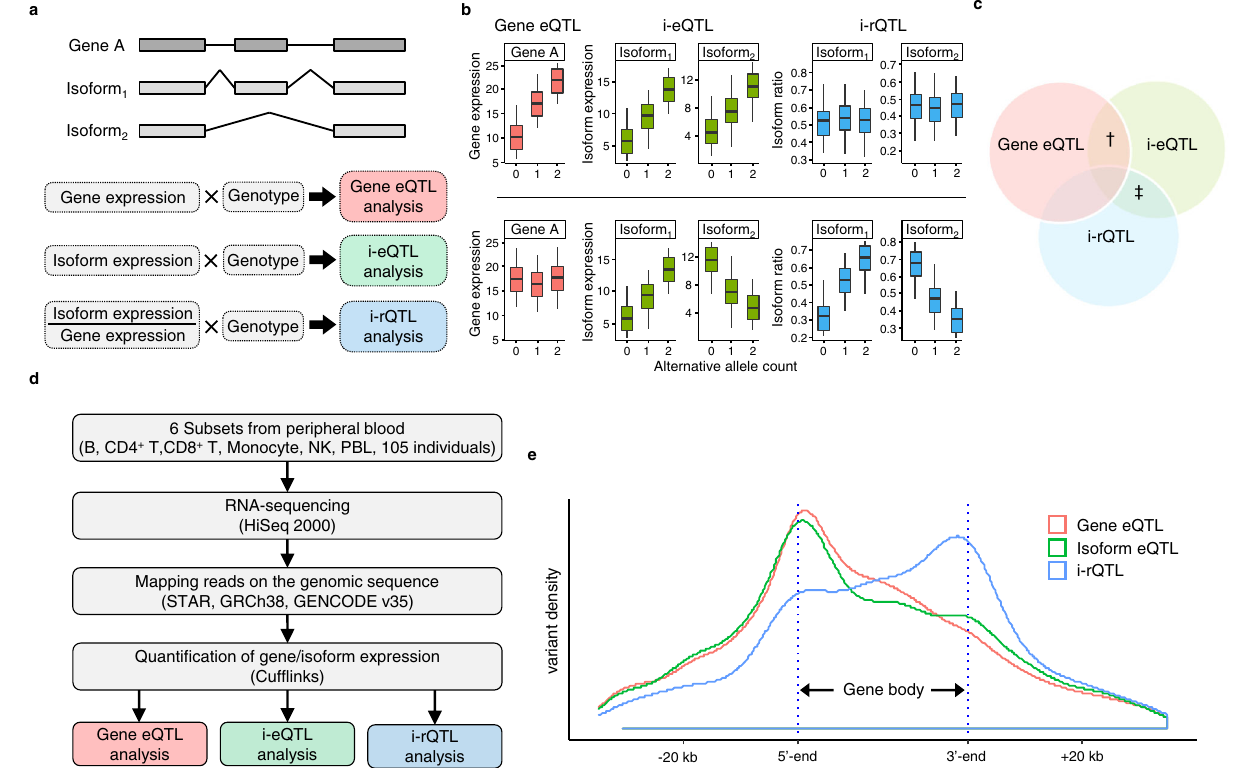
Fig. 1 | Three types of quantitative trait loci (QTLs); gene eQTL, isoform eQTL andi-rQTL.a GeneAhas2isoforms, isoform1 and isoform2.Alocus affectingthe expressionlevelofgeneAisde fi nedasgeneeQTL.Alocusaffectingtheexpression levelofisoform1and/or2isde fi nedasi-eQTL(isoformeQTL).Alocusaffectingthe isoform ratio of isoform 1 and/or 2 is de fi ned as i-rQTL (isoform ratio QTL). b An example of gene having both gene-eQTL and i-eQTL effects but not i-rQTL effect (theupperpanel)andthathavingbothi-eQTLandi-rQTLeffectsbutnotgene-eQTL